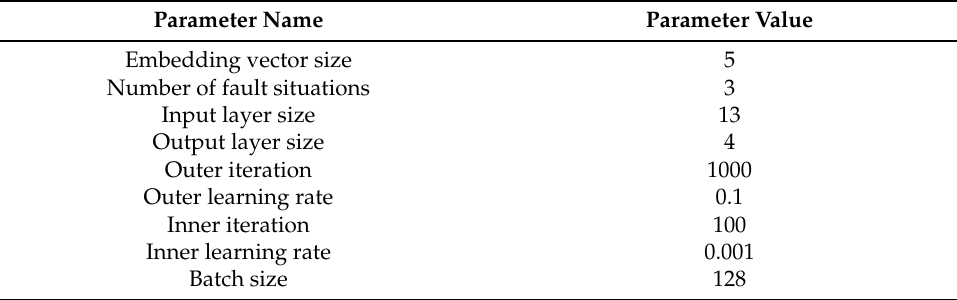
Figure 5. The structure of situation embedding networks. Table 5. Parameters of situation embedding